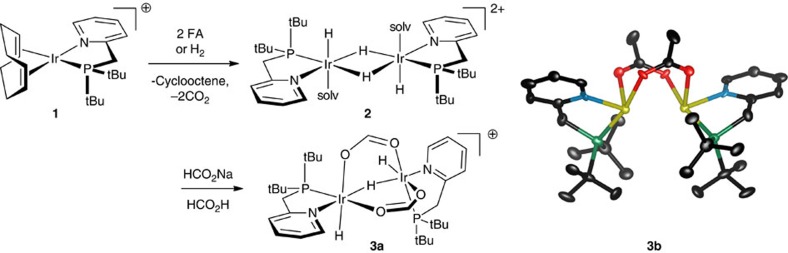
Catalyst initiation and molecular structure of active catalyst homologue 3b.3b={[(tBu2PCH2(2-py))Ir(H)]2(μ2-H)(μ2-κ,κ′-O2CCH3)2}+. Hydrogen atoms omitted. Ellipsoids are drawn at the 50% probability level. counterion, trifluoromethanesulfonate; solv, solvent.